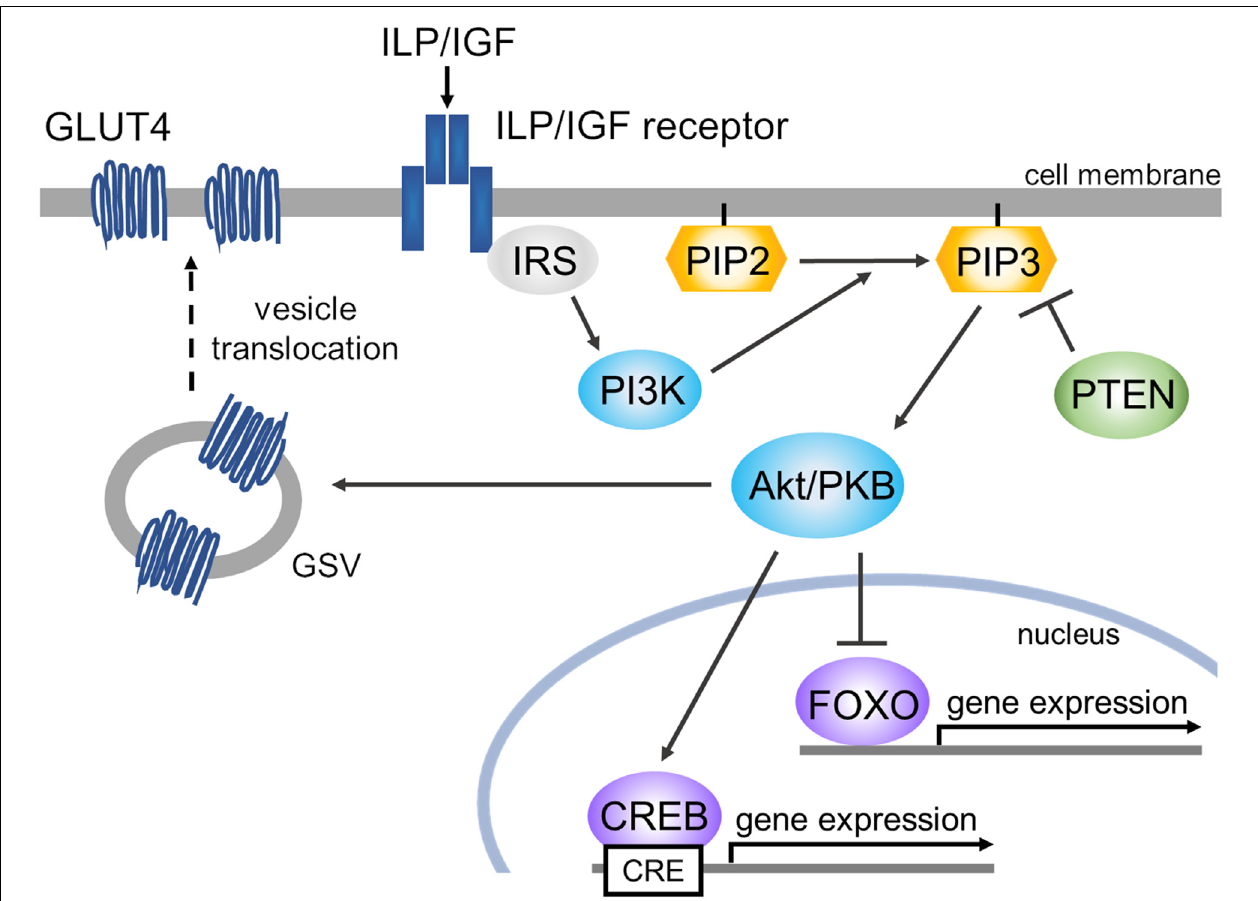
FIGURE 4 | Scheme of deduced ILP/IGF signaling cascades for memory enhancement. There are three main pathways: (1) Akt/PKB phosphorylates CREB (e.g., CREB1 in Lymnaea ), resulting in gene expression. (2) Akt/PKB phosphorylates FOXO, inducing its secession from DNA. (3) Akt translocates GSV to the membrane, resulting in the expression of GLUT4. The ILP/IGF receptors are called InR in Drosophila , DAF-2/IGFR (insulin/IGF-1 transmembrane receptor) in C. elegans , and MIPR in Lymnaea . Abbreviations: Akt/PKB, Akt/protein kinase B; CREB, cAMP response element-binding protein; FOXO, forkhead box protein O; GLUT4, glucose transporter isoform 4; GSV, GLUT4 storage vesicle; IRS, insulin receptor substrate; PI3K, phosphoinositide-3-kinase; PIP2, phosphatidylinositol 4,5-bisphosphate; PIP3, phosphatidylinositol 3,4,5-trisphosphate; PTEN, phosphatase and tensin homolog deleted on chromosome 10 (i.e., PIP3 phosphatase).